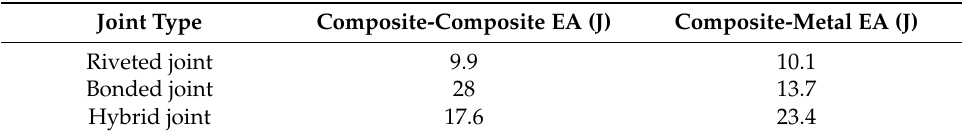
Table 7. Experimental results for energy absorption (EA) by the riveted, adhesive bonded, and hybrid joints in composite-composite and composite-metal configurations.